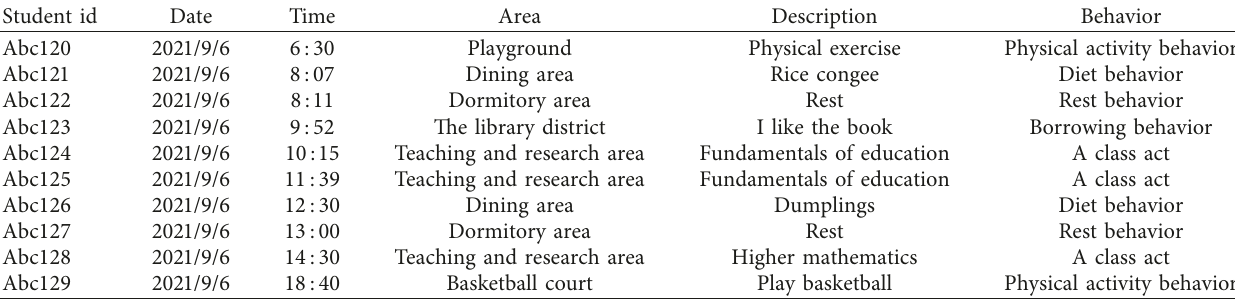
Table 3: Active data instances and behavior labels in the